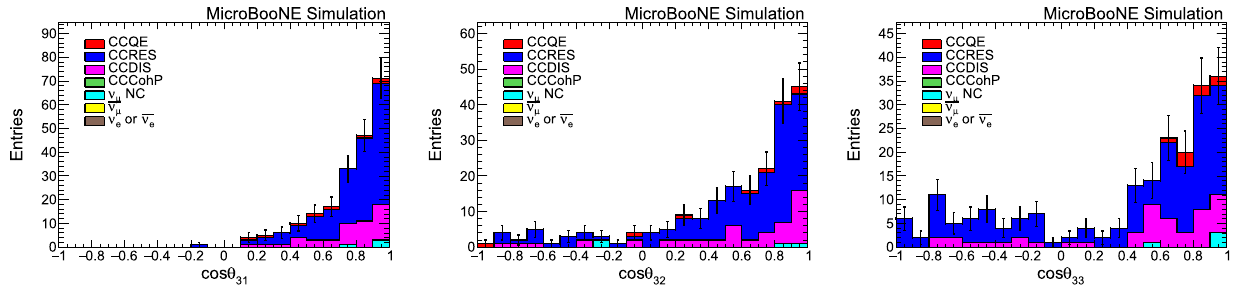
Fig. 34 Multiplicity = 3 track length distribution for candidate muon (left); for second longest track (middle); for shortest track (right) from GENIE default MC. Black error bars represent MC statistical uncertainties